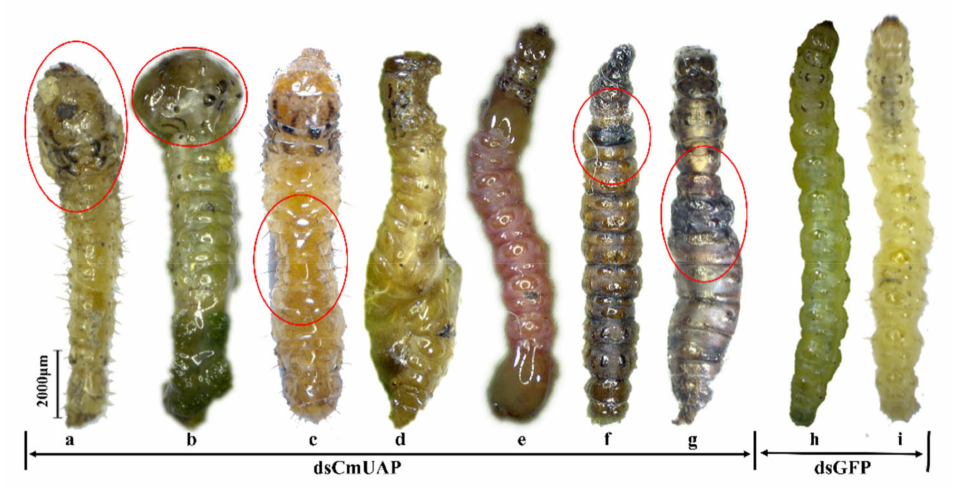
Figure 9. Abnormal morphology of C. medinalis larvae after dsRNA injection. ( a – g ), phenotypes of larvae after ds CmUAP injection; ( h ) and ( i ), ds GFP -injected larvae. Red circles indicate the phenotypic changes of the larvae. Scale bar represents 2000 µ